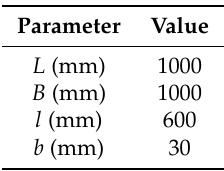
Table 1. Fuselage dimensions; see Figure 5.